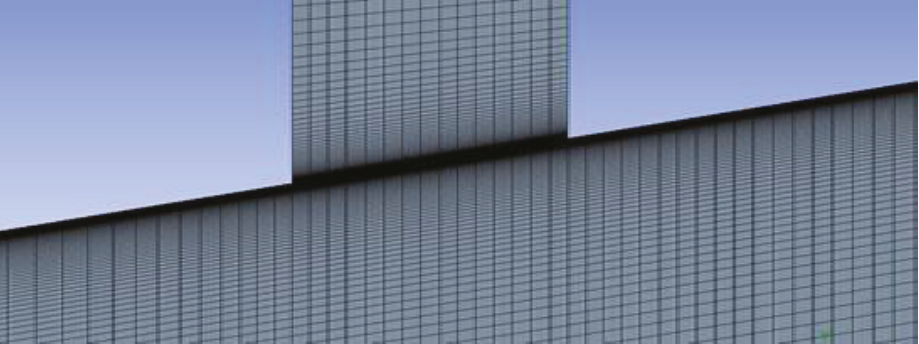
Figure 9: Near view at the injection slot grid 2.